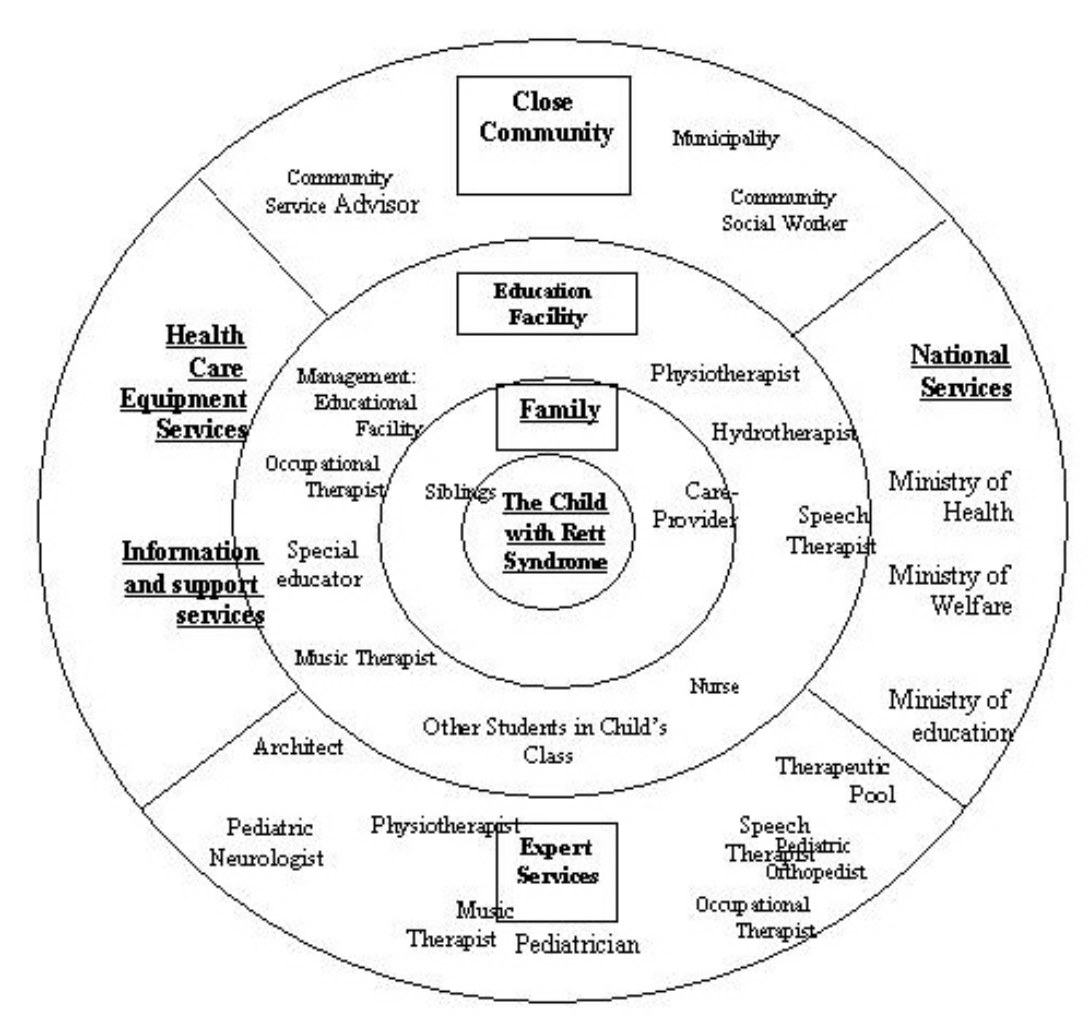
FIGURE 1. Schematic drawing of the different participants influencing supplementary treatment and assistive technology for individuals with RS, presenting the complexity of this issue and the many bodies involved in administering